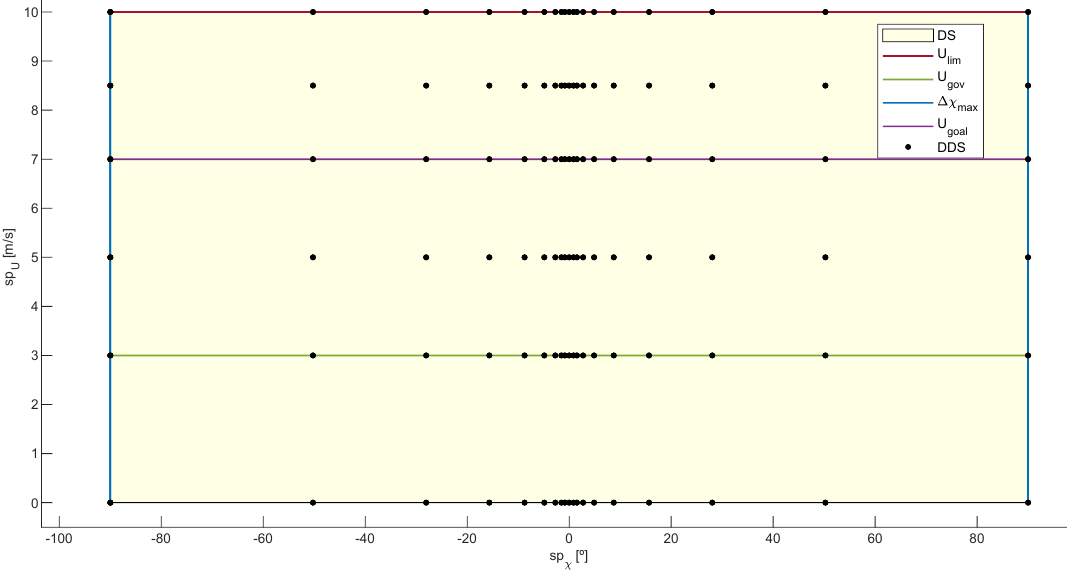
Figure 7. Discretization of space (16). Settings: χ ( k ) = 0 ◦ , n χ = 9, τ χ = 1.7 and n U =